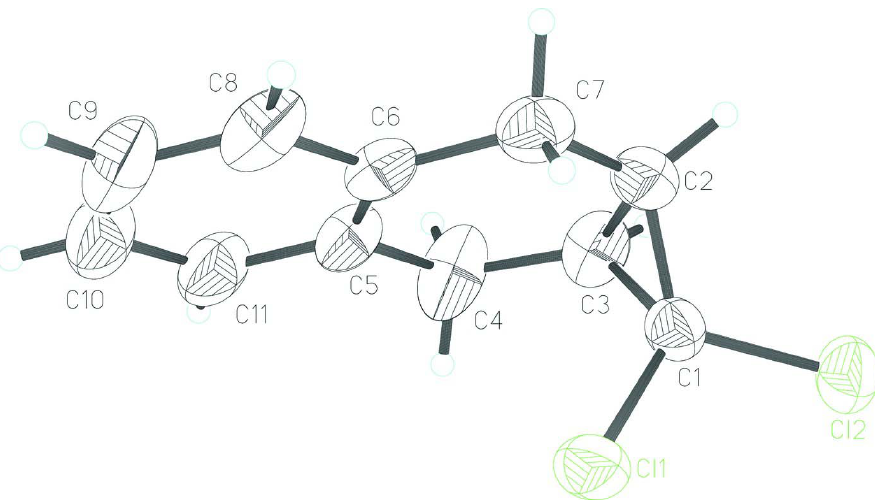
Figure 1 The molecular structure of ( I ), with displacement ellipsoids drawn at the 40% probability level. H atoms are shown as spheres of arbitrary radius.